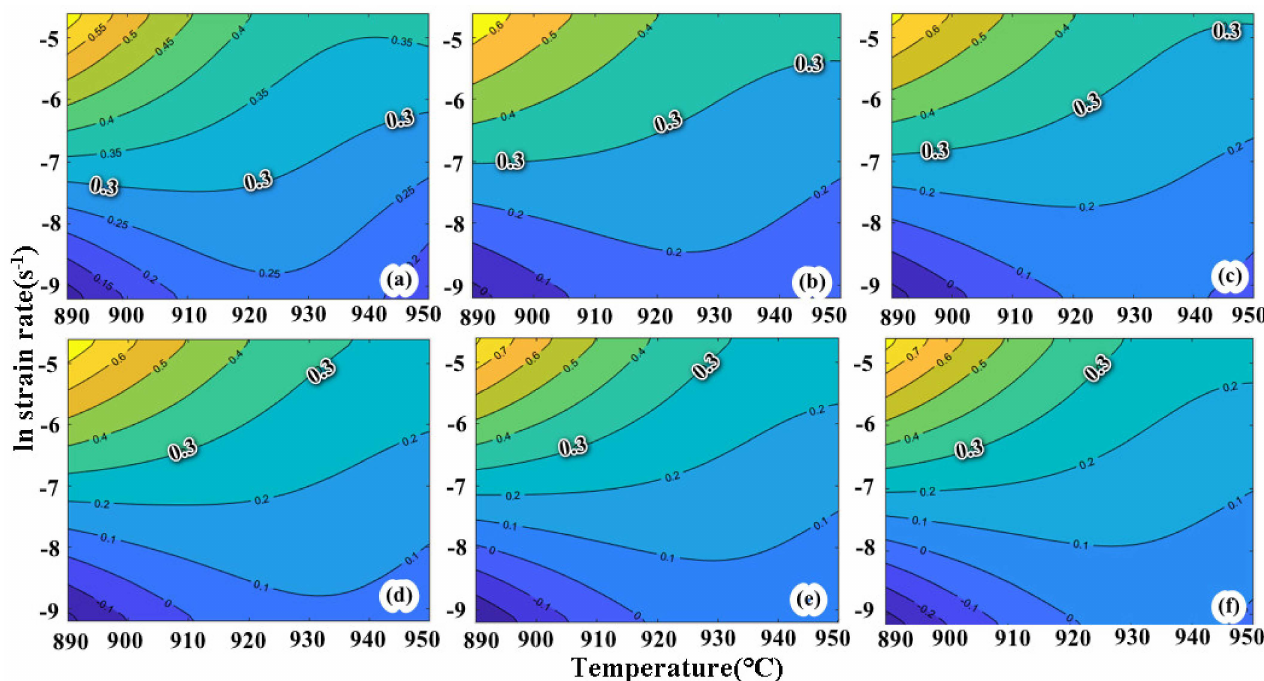
Figure 4. Maps of the strain rate sensitivity factor at different strains: ( a ) ε = 0.2, ( b ) ε = 0.3, ( c ) ε = 0.4, ( d ) ε = 0.5, ( e ) ε = 0.6, and ( f ) ε = 0.7.